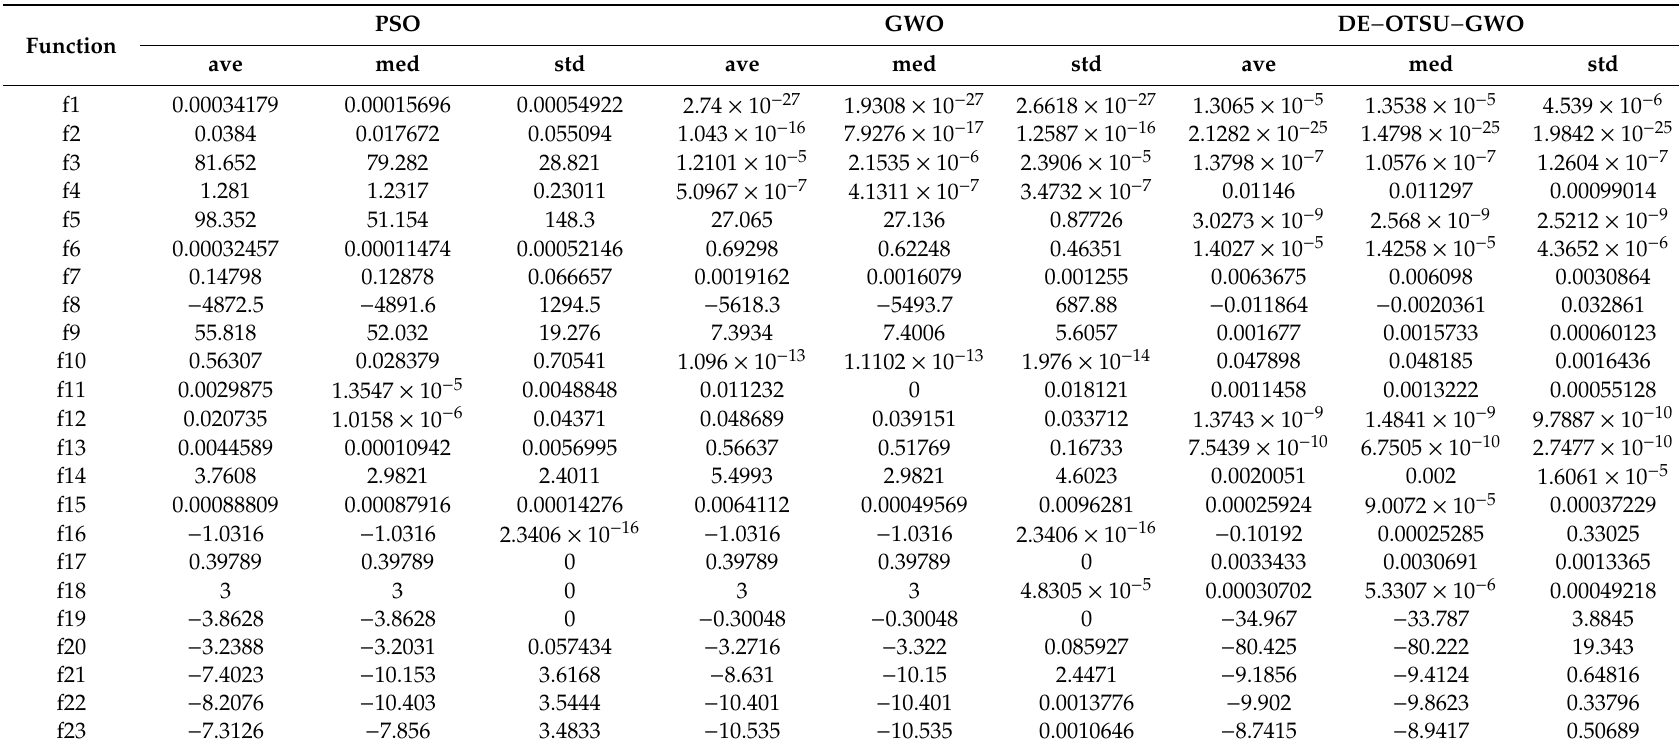
Table 5. Result of benchmark